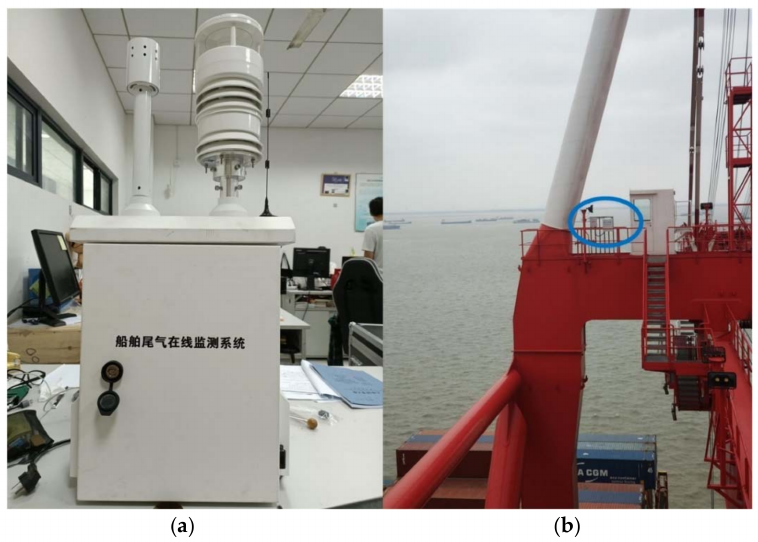
Figure 4. ( a ) Hardware photo (the title on it means on-line monitoring system of ship exhaust) and ( b ) monitoring